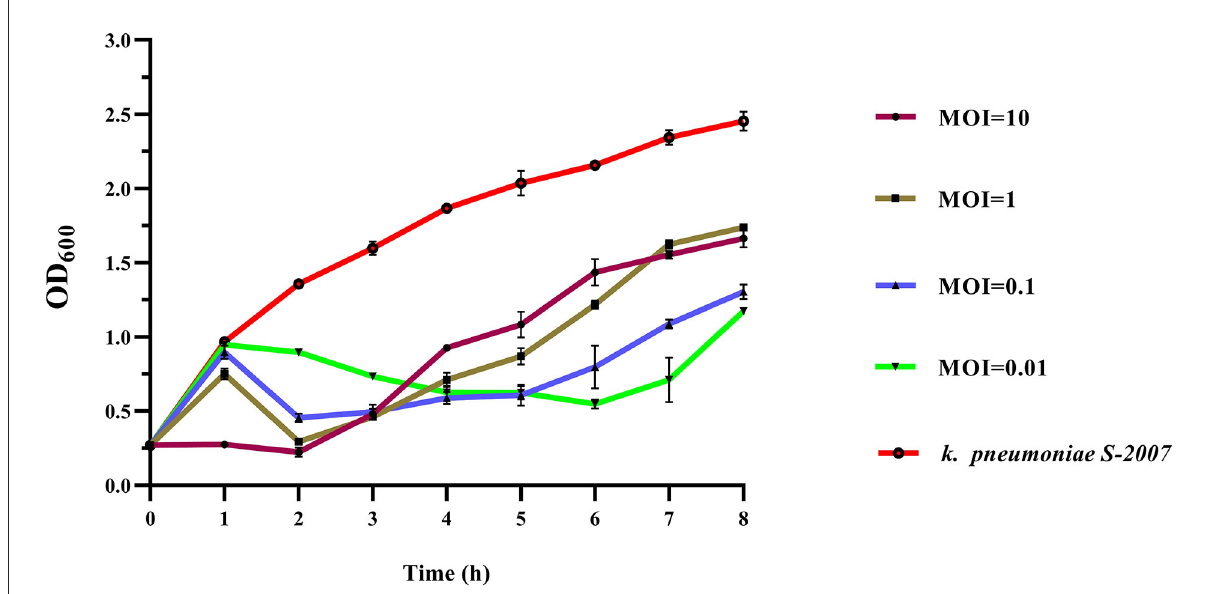
FIGURE6 Growth curves of K. pneumoniae S-2007 infected with BUCT541 at different MOIs.